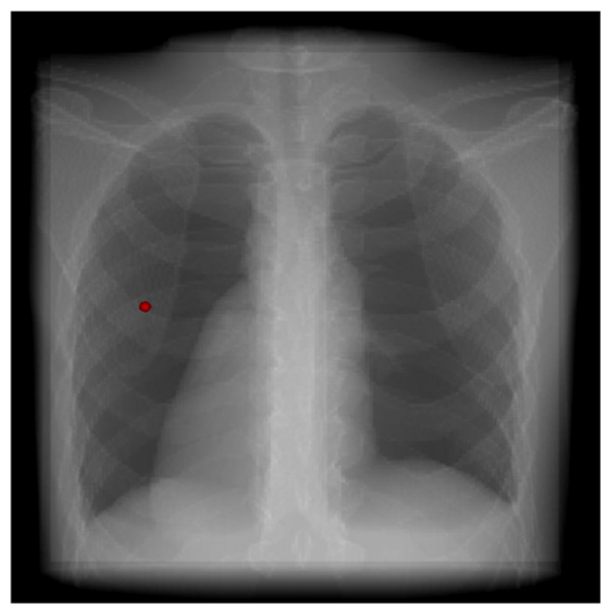
Figure 19. Dual-modal enhancement effect for slit scanning